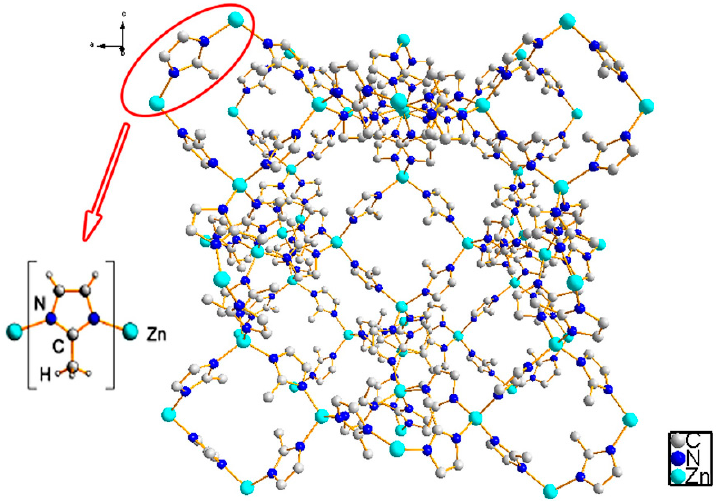
Figure 4. Structure of ZIF-8. Reproduced with permission from http://www.chemtube3d.com/solidstate/MOF-ZIF8.htm .